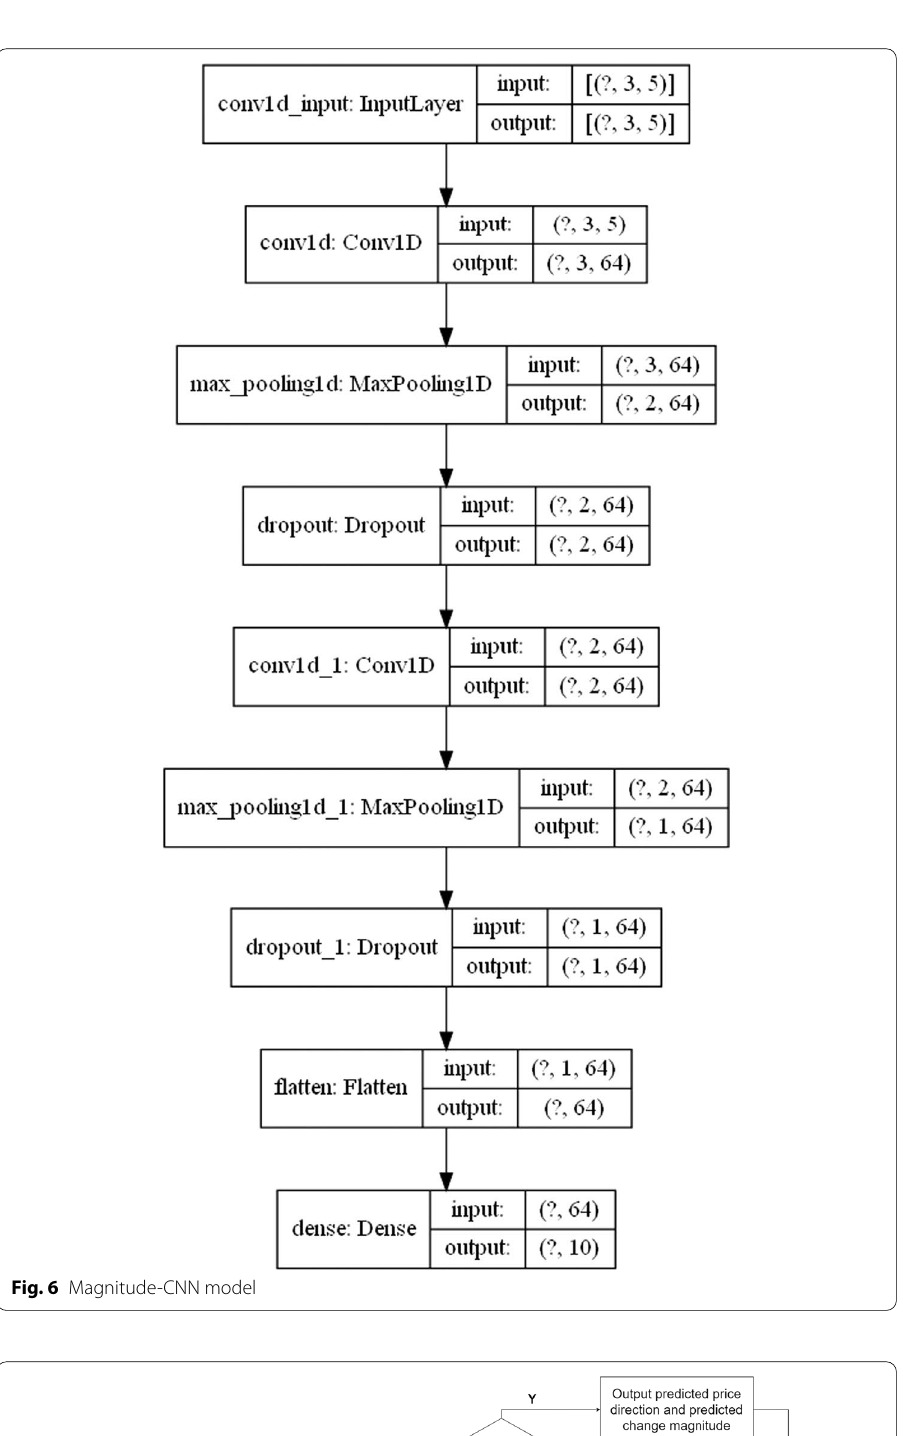
Fig. 6 Magnitude-CNN model